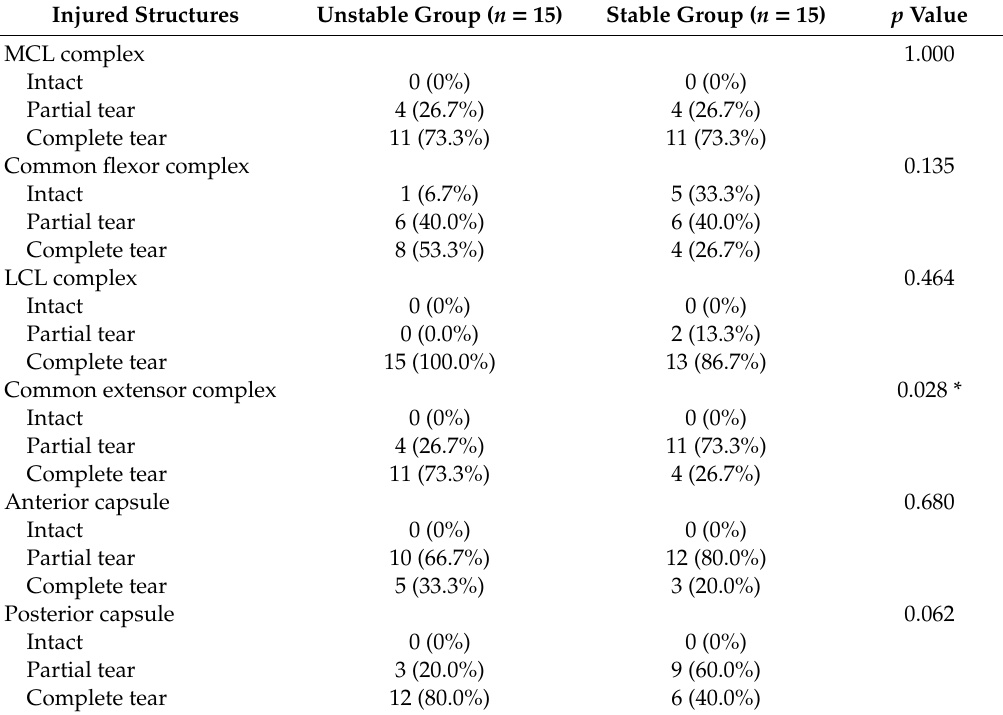
Table 4. Incidence of injured structures in unstable and stable